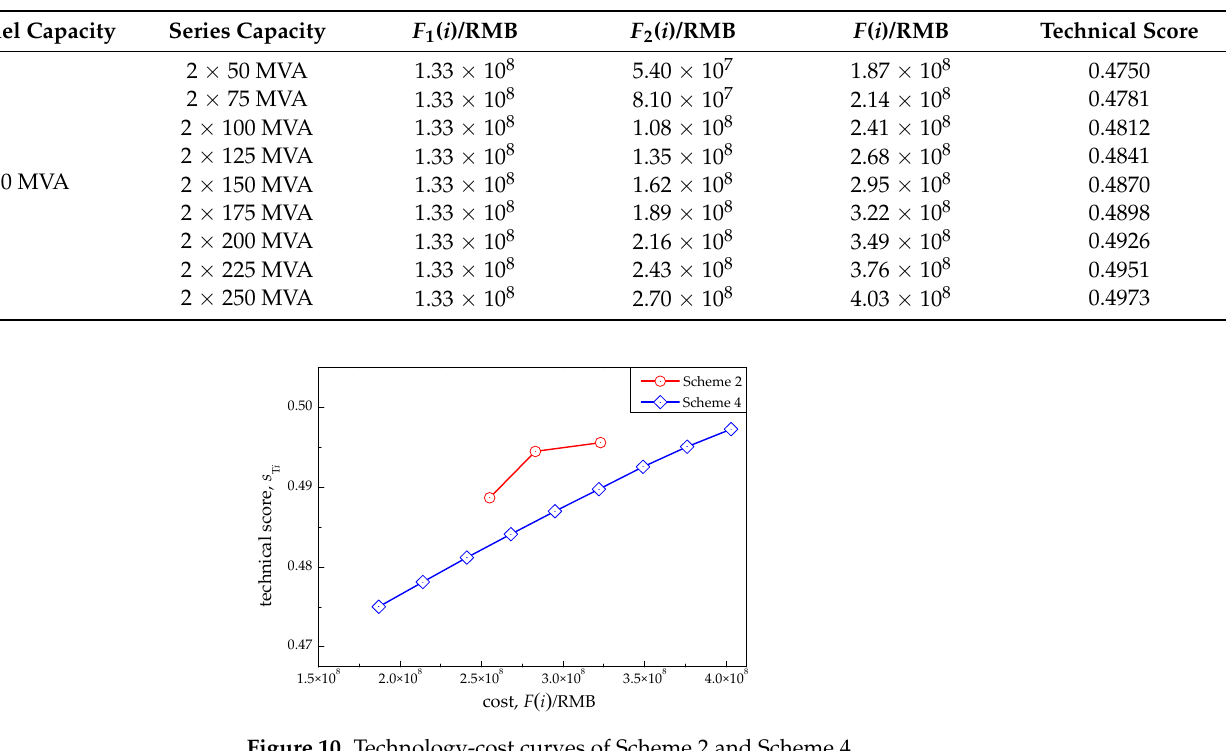
Figure 10. Technology-cost curves of Scheme 2 and Scheme 4.